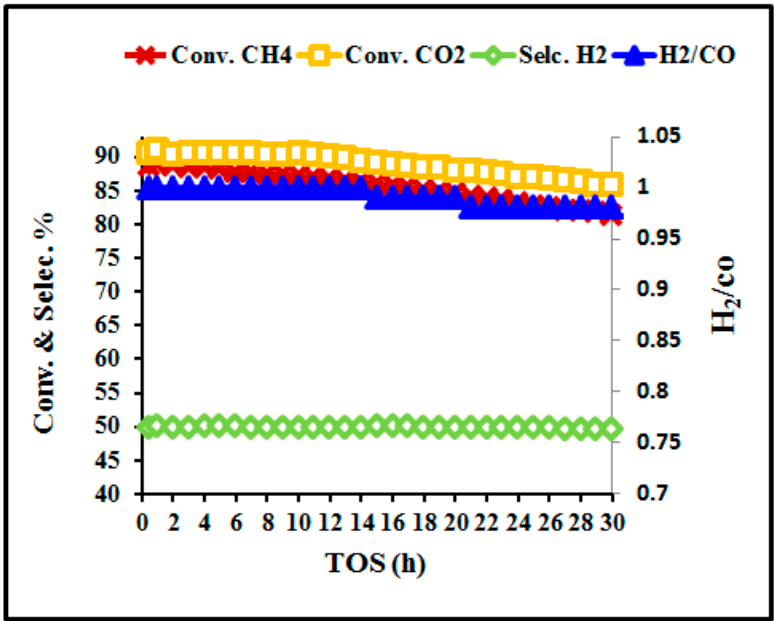
Figure 10. CH 4 & CO 2 conversions, H 2 selectivity & H 2 /CO ratio versus time on stream (TOS) for 5%Ni+2.0%Ga/MCM-41 catalyst at Tr = 800 °C; WHSV = 39,000 mL/min·gcat). Total flow rate = 40 mL/min (CH 4 = 30 mL/min, CO 2 = 30 mL/min & N 2 = 5 mL/min).